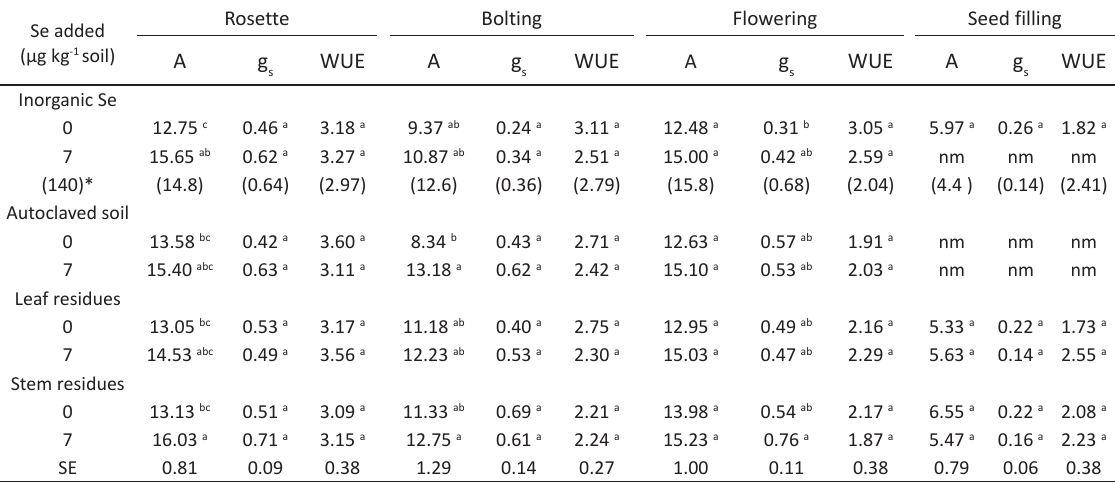
, mol m -2 s- 1 ) and water use efficiency (WUE) values of B. s